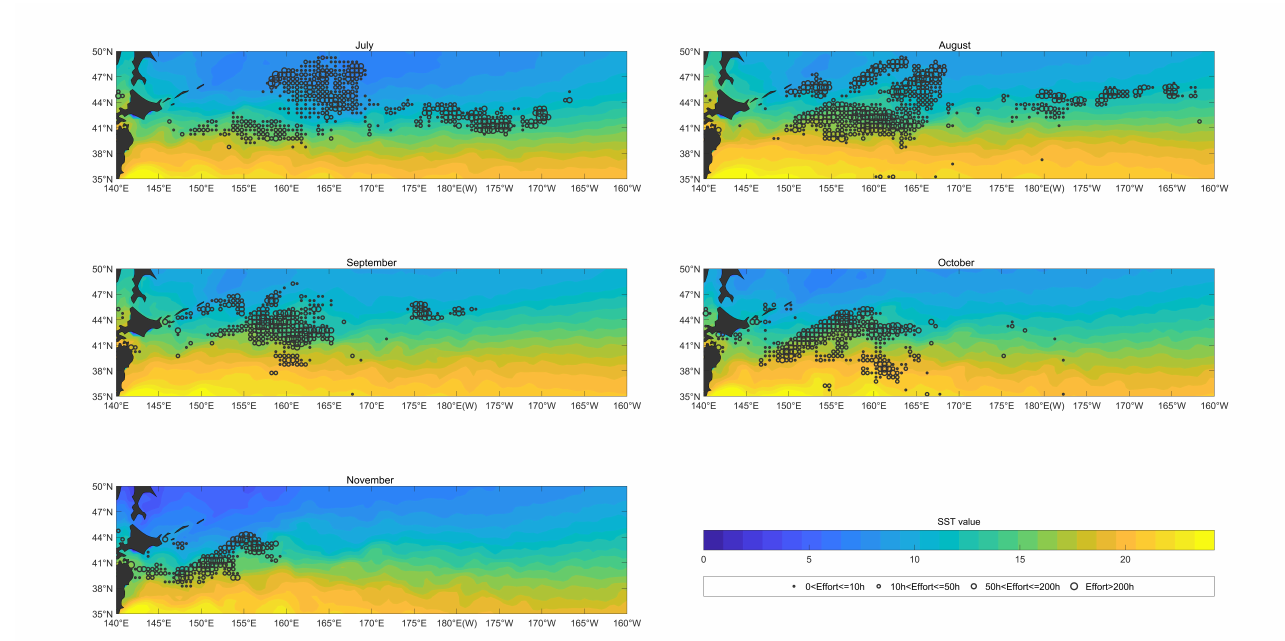
Figure 11. The overlay map of SST (color shading; units: ◦ C) and monthly fishing efforts (circle; units: h) of O. bartramii in the North Pacific Ocean from July to November during 2017 to 2020.